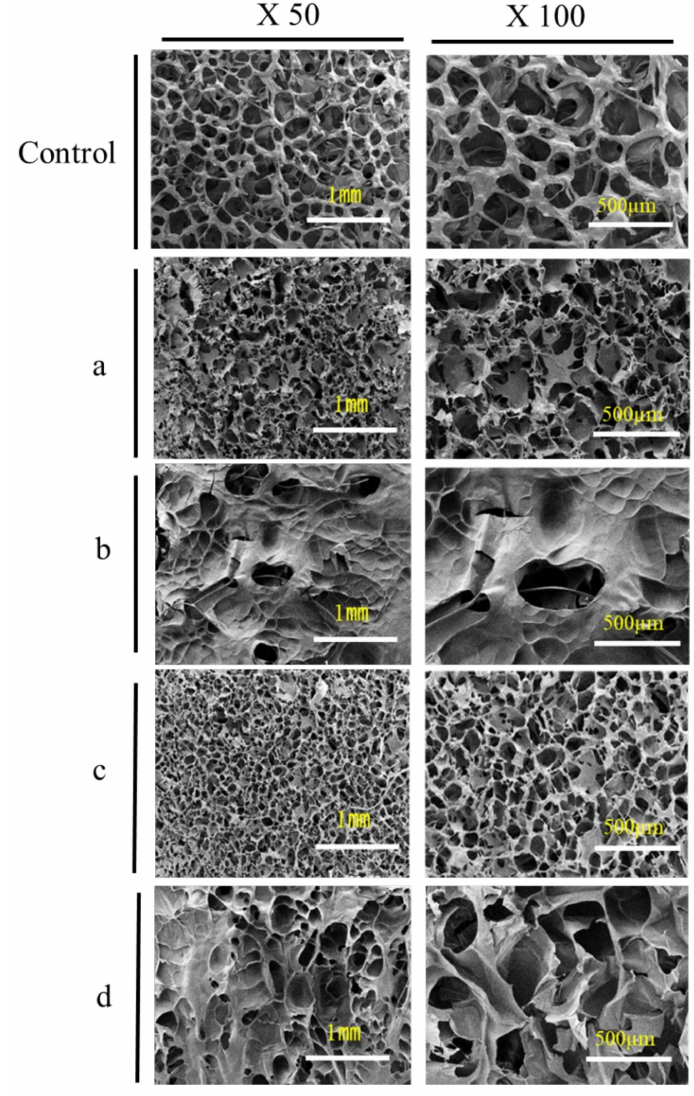
Figure 4. Morphological characterization with field emission scanning electron microscope (FE-SEM); control sponge, ( a ) Alg-CMC ratio (5:5); ( b ) Alg-CMC ratio (5:5) with dextran; ( c ) Alg-CMC ratio (7:3);